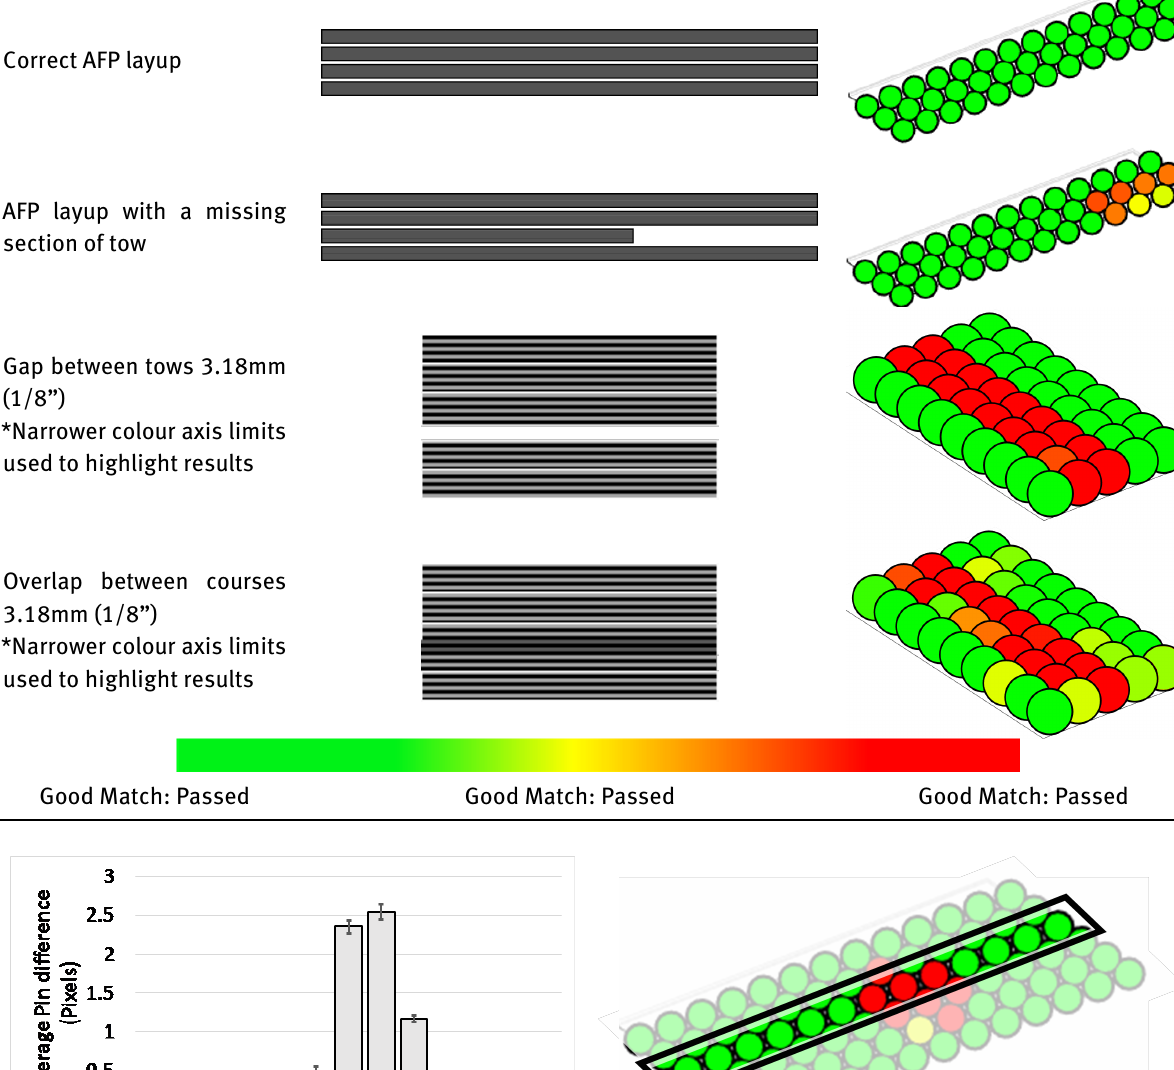
Table 3: Results of TacTip scans on a simulated AFP layup.